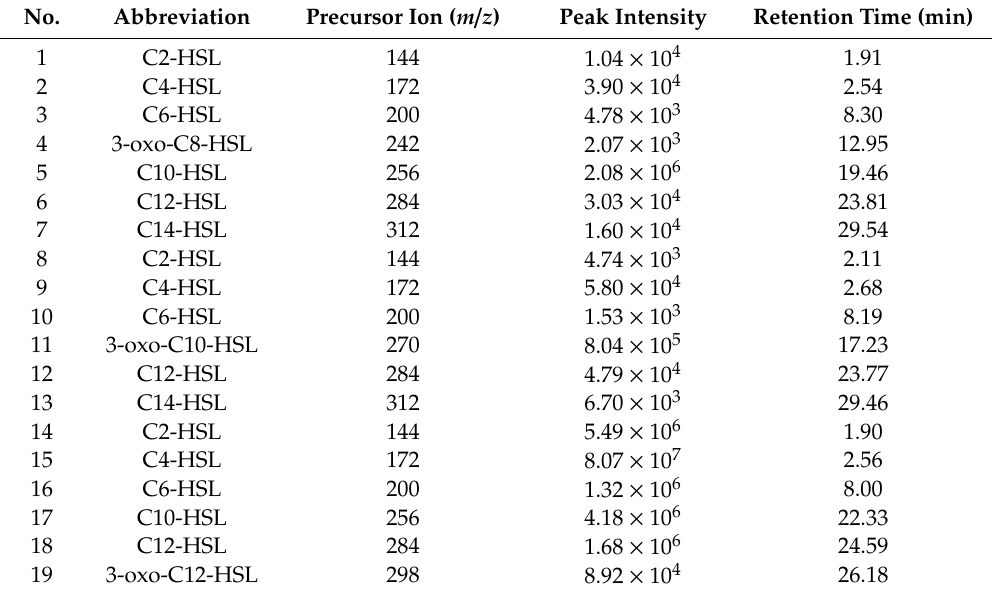
Table 1. Quorum-sensing system AHL signaling molecules